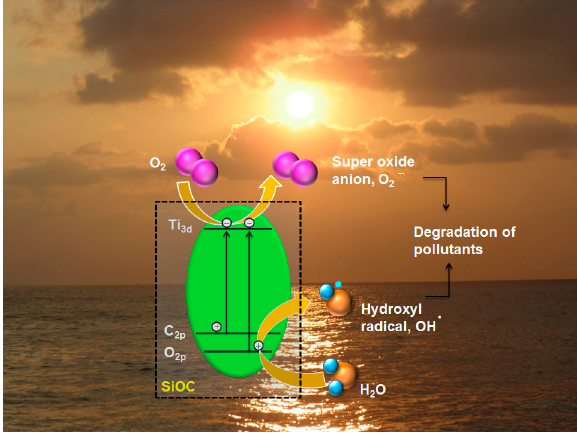
Figure 15. Schematic representation of band gap reduction mechanism and degradation process. In general, low concentration of dye can only be removed by the photocatalytic degradation